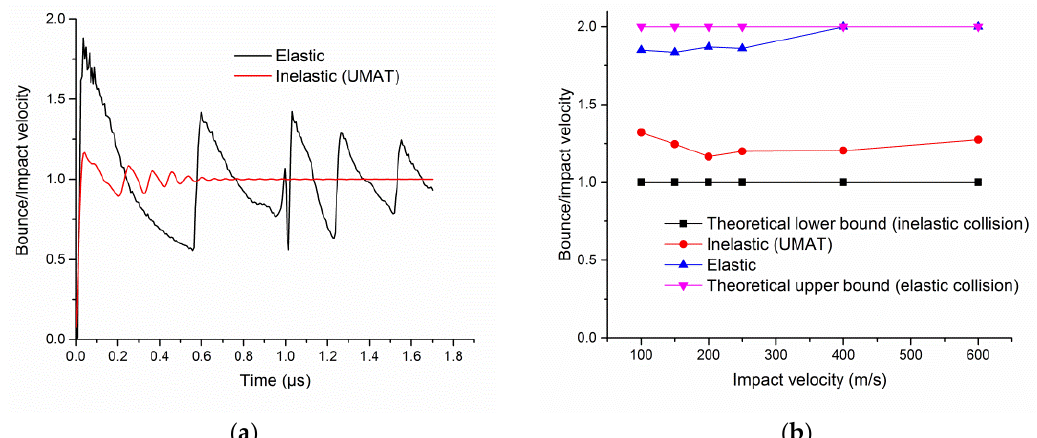
Figure 3. Ratio of bounce velocity to impact velocity for a rigid 1.0 mm radius cylindrical projectile ( a ) at 200 m/s; and ( b ) function of impact velocity.